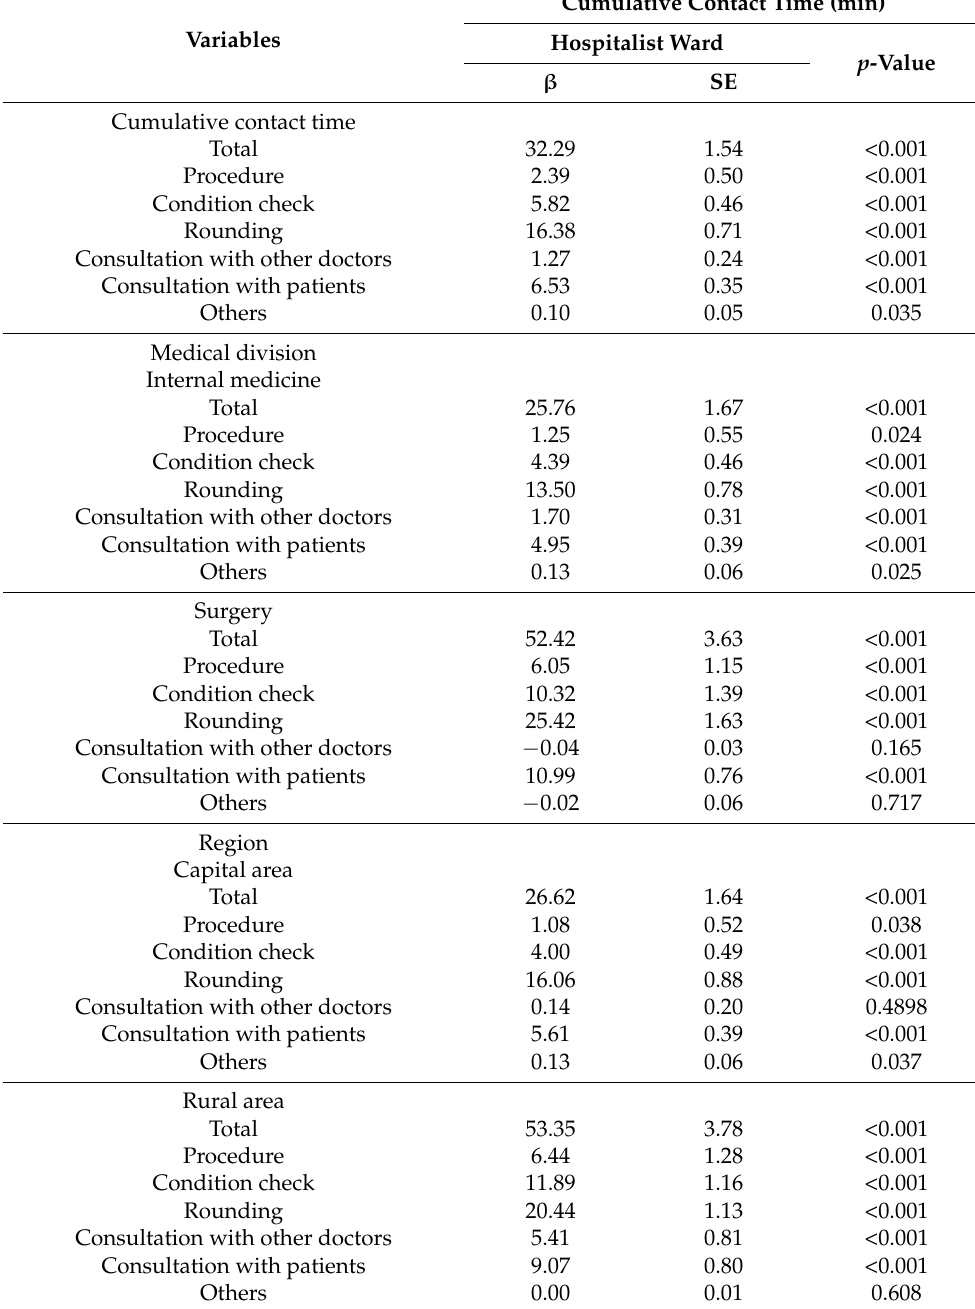
Table 4. Results of regression analysis on cumulative contact time by the purpose of patient–doctor contact during the hospital stays +